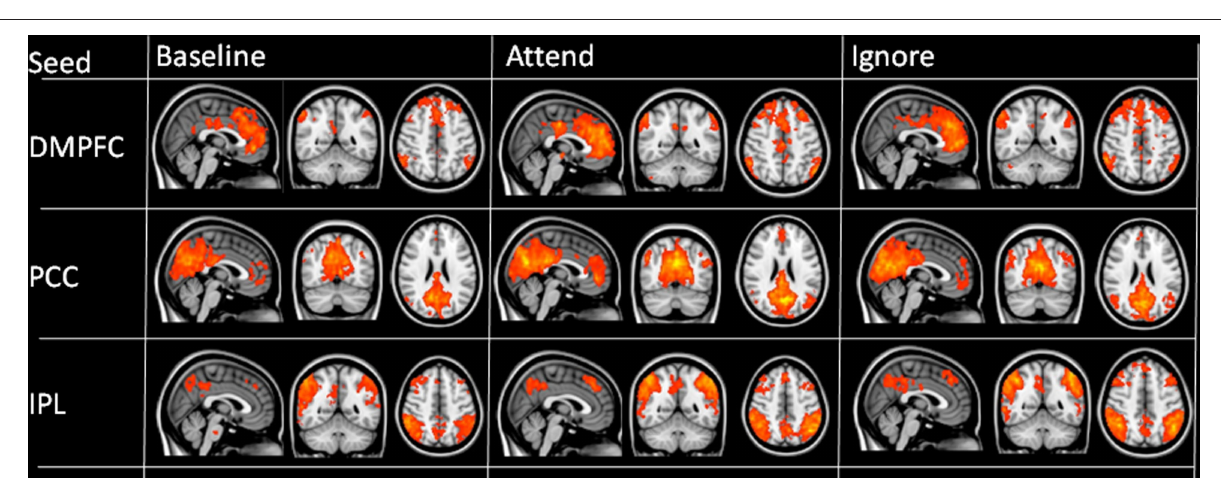
FIguRe 5 | Functional connectivity maps for each of the three conditions obtained using structural seeds as defined in text. Images thresholded at p < 0.005 with a 20-voxel cluster threshold; color range from 2 (red) to > 5 (yellow).